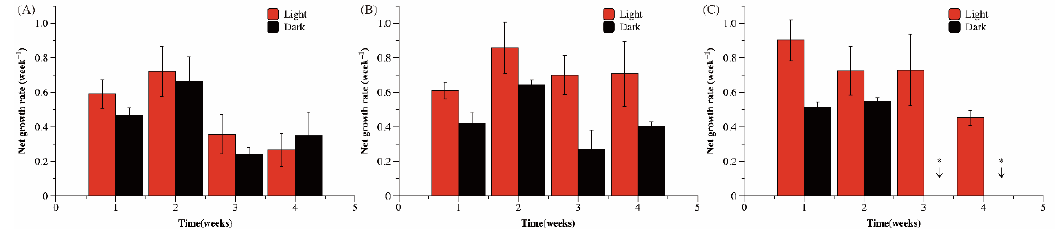
Figure 3. After overwintering for 1 – 4 weeks under different conditions (( A ) 4 °C; ( B ) 8 °C; ( C ) 12 °C), Ma cells were cultured at 25 °C in the light. The net growth rate was used to represent the re-growth ability of Ma cells. * Represents a negative growth rate.